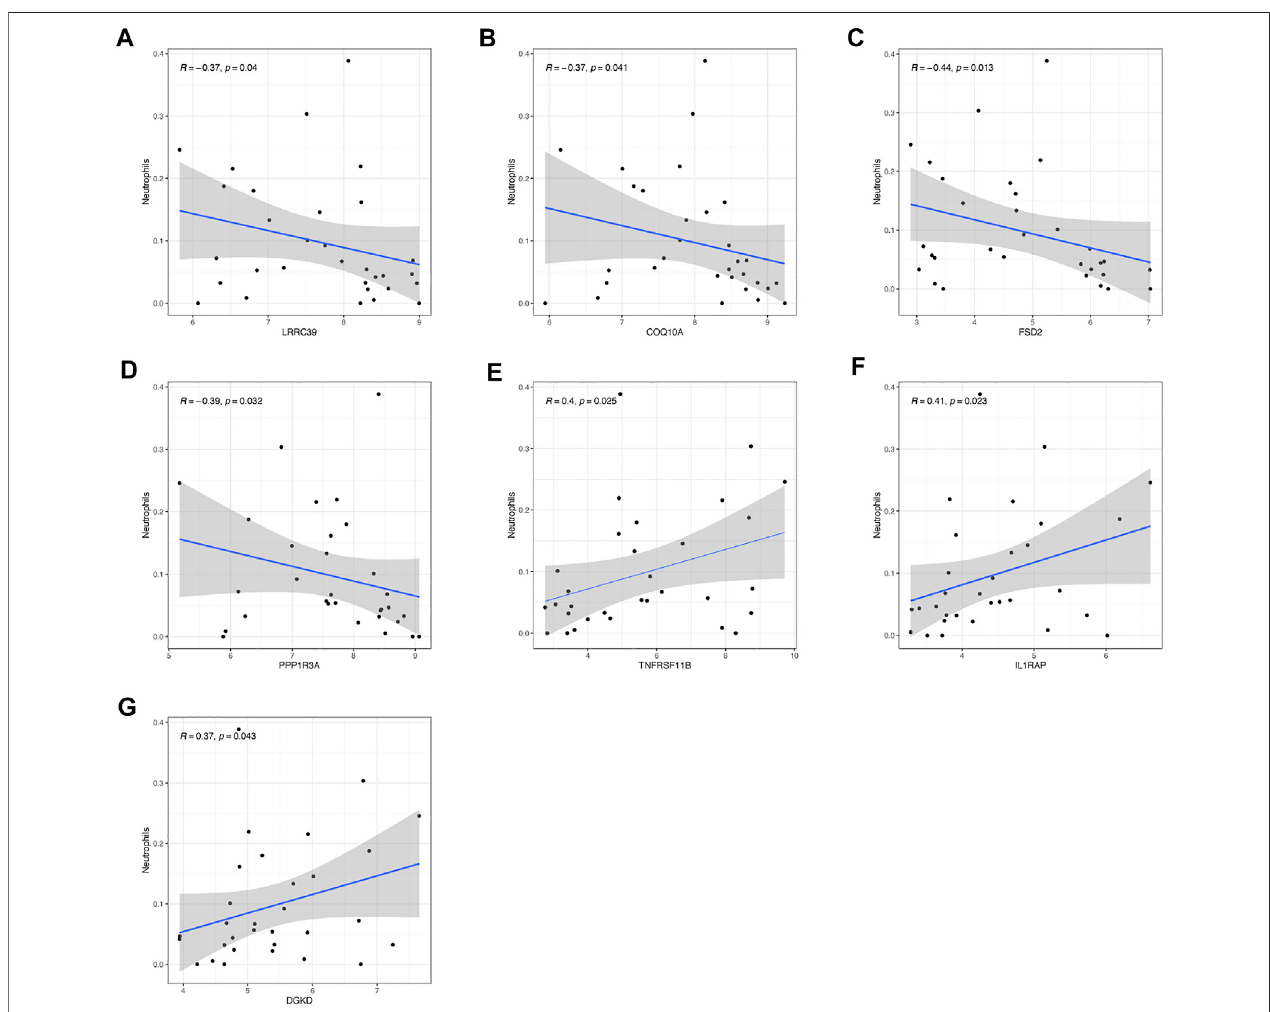
FIGURE 7 | Relationship of hub genes with immunocytes. The connection between neutrophils and (A) LRRC39 , (B) COQ10A , (C) FSD2 , (D) PPP1R3A , (E) TNFRSF11B , (F) IL1RAP , and (G) DGKD .